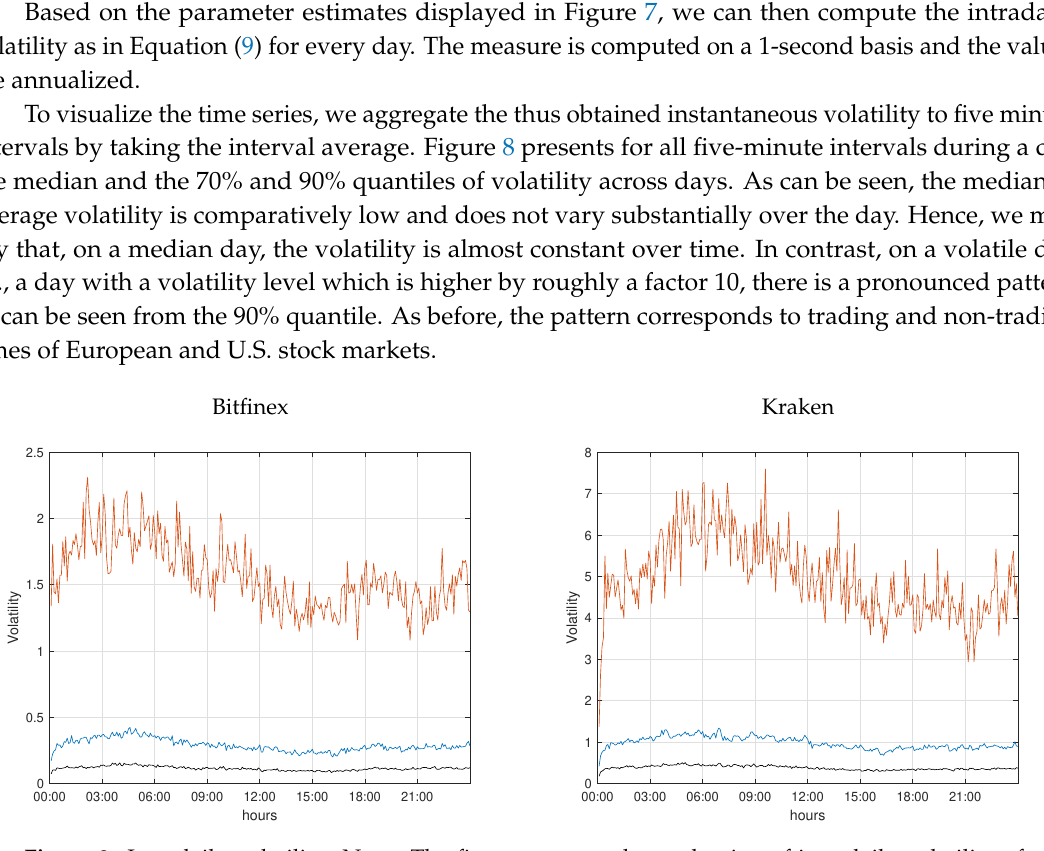
Figure 8. Intradaily volatility. Note. The figure presents the evoluation of intradaily volatility of Bitfinex (left plot) and Kraken (right plot). The black line is the the median of the daily 5-min-interval volatility averages, blue is the 70% and orange the 90% quantile of the daily 5-min-interval